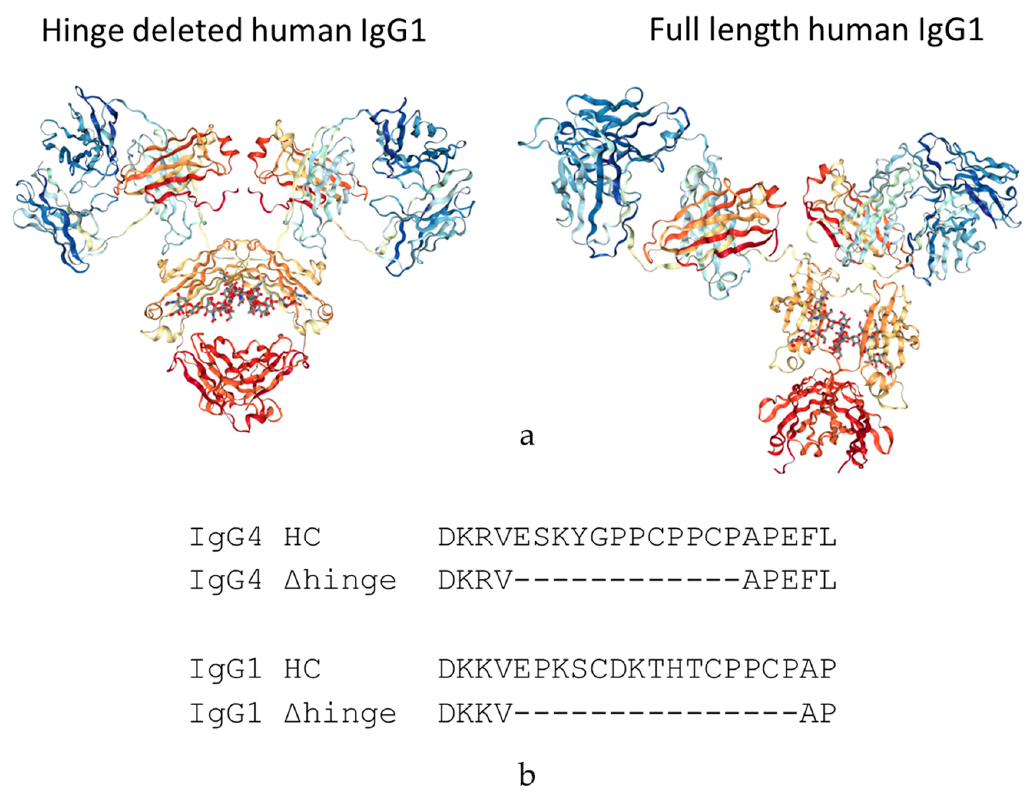
Figure 1. ( a ) Three-dimensional representation of the crystal structures of a human IgG1 (PDB 1HZH) and the hinge deleted Mcg Antibody (PDB 1MCO). ( b ) Sequence alignment of the IgG1 and IgG4 hinge (IgG1 HC, IgG4 HC) and resulting sequence after deletion (IgG1 Δ hinge and IgG4 Δ hinge).